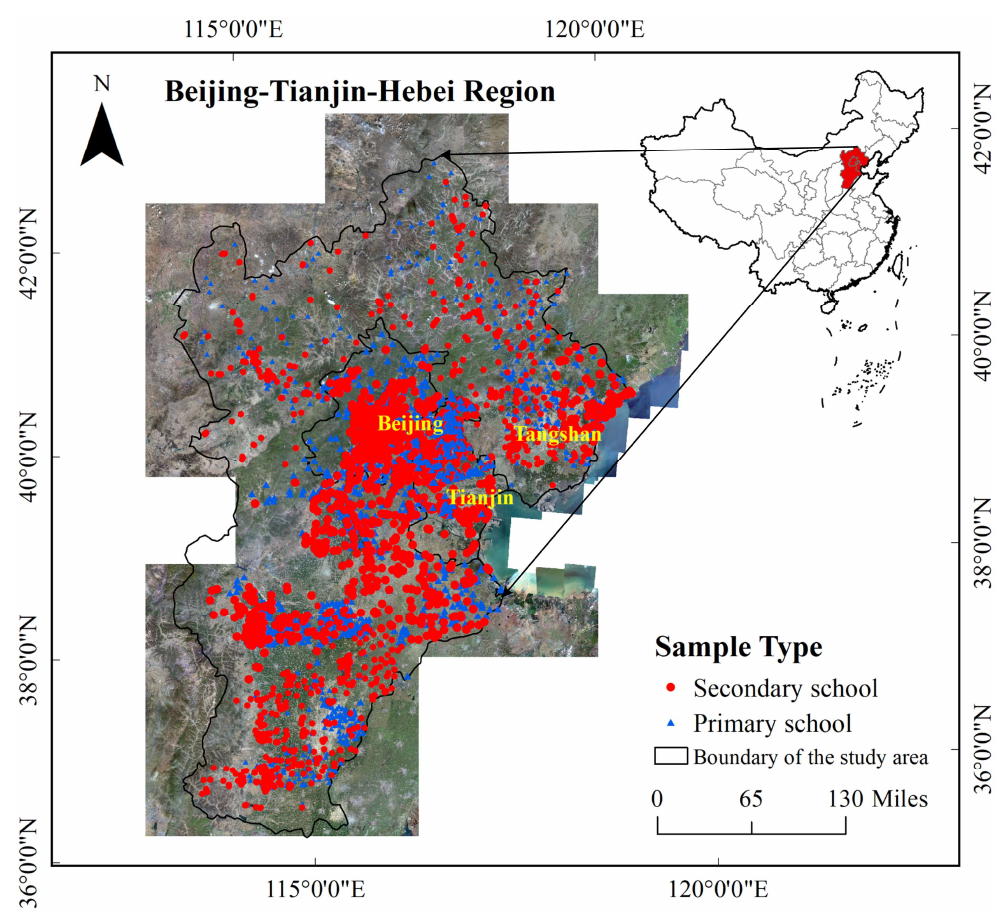
Figure 7. Display of study area. Note: the secondary schools and primary schools are plotted by the red circle and blue triangle, respectively.